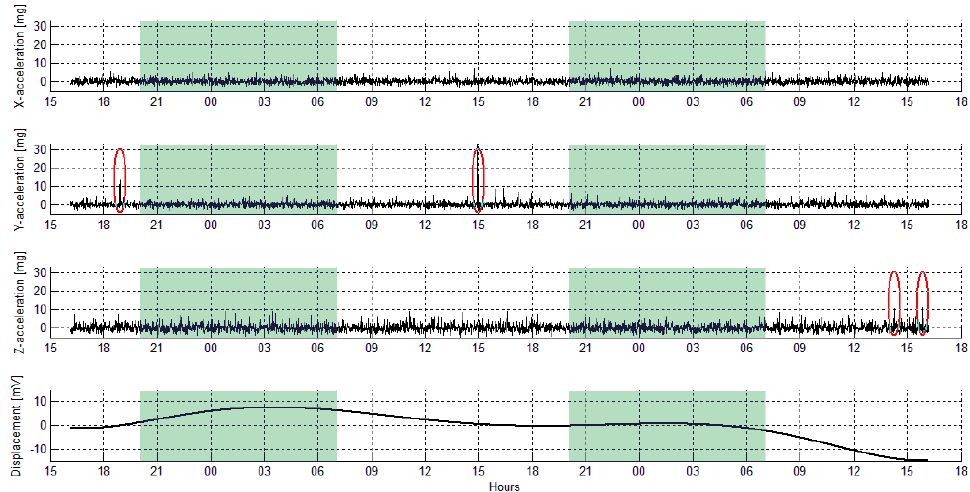
Figure 12. Results registered by node 1 (2-day interval).